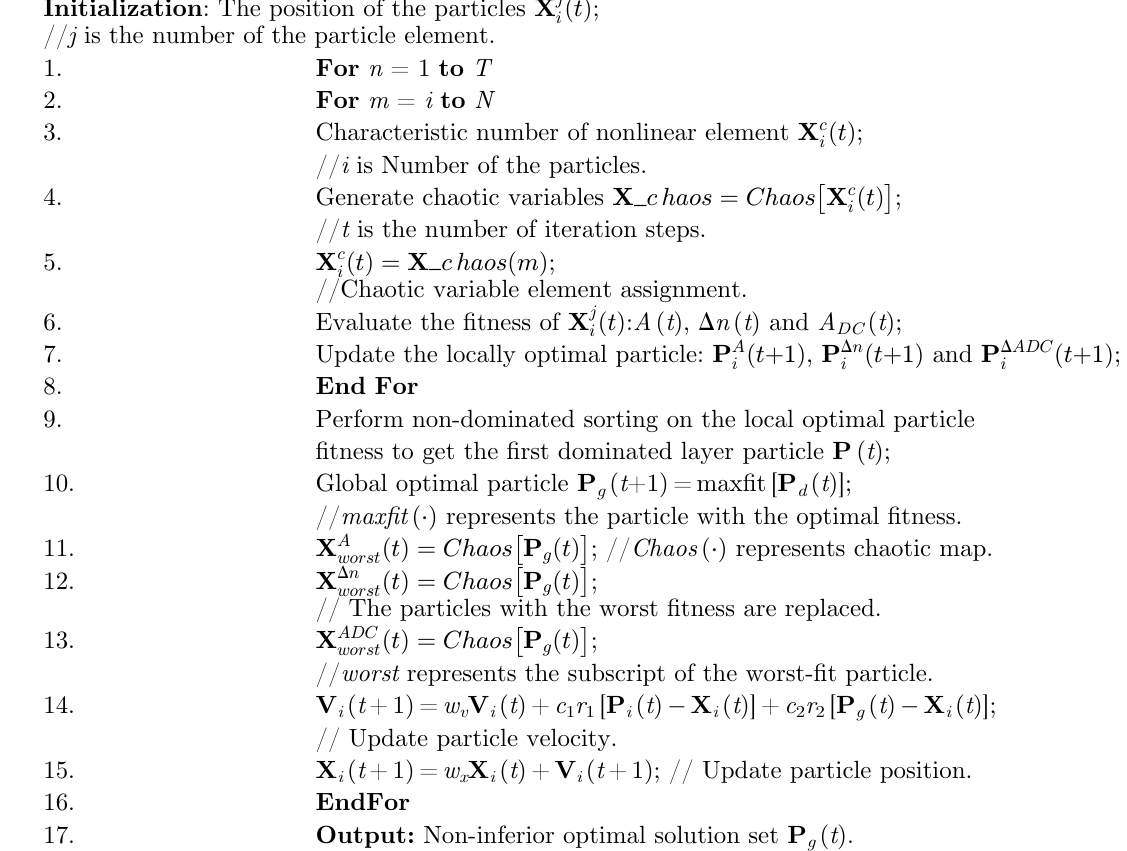
Table 1. Pseudo code of the CIMPSO algorithm. Input : Learning factor c , c ; Particle swarm size N ; Number of iterations T ; Velocity inertia weight w 1 2 ; Expansion factors a and b ; Control parameter m ; Chaotic variable element numbering c . inertia weight w x Initialization : The position of the particles X j t ð Þ ; i // j is the number of the particle